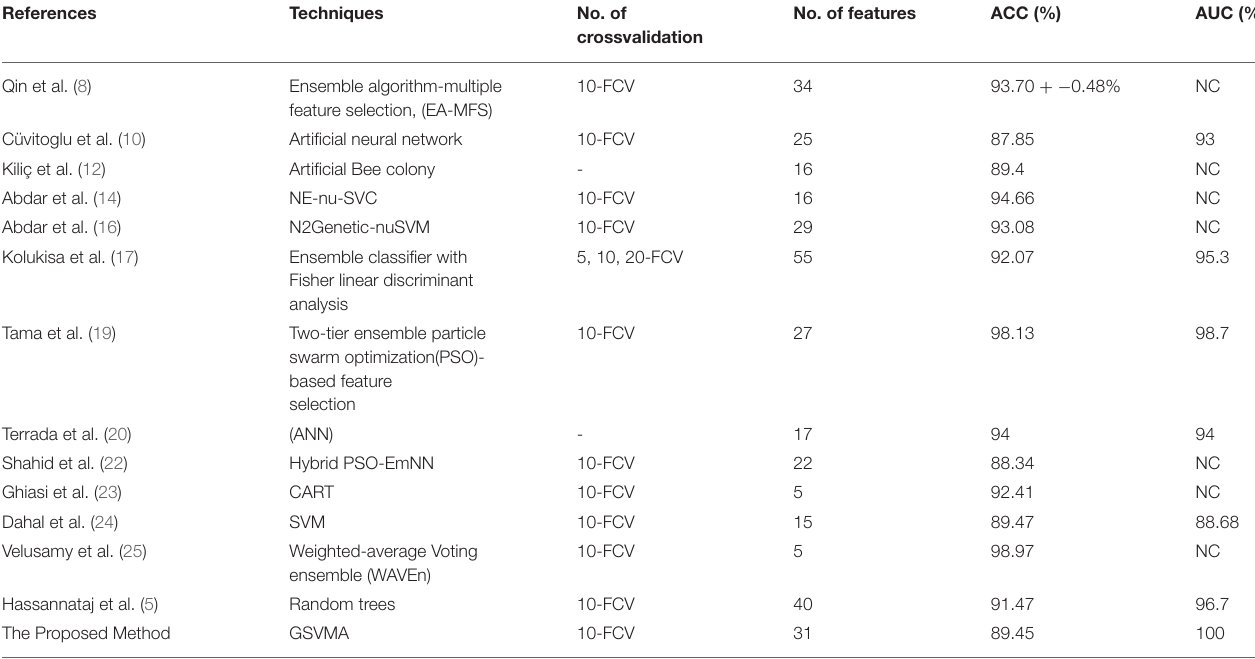
TABLE 8 | Comparison between the proposed GSVMA method and the work of other researchers based on the original Z-Alizadeh Sani